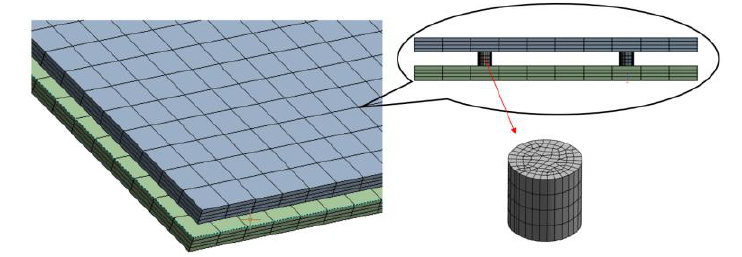
Figure 5. Meshing in finite element analysis (3-D).